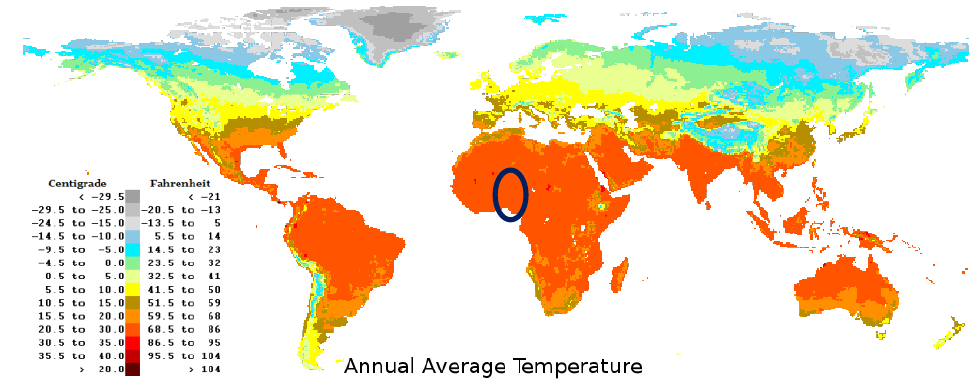
Fig. 4. Annual average temperatures of world zones scaled in Centigrade and Fahrenheit.